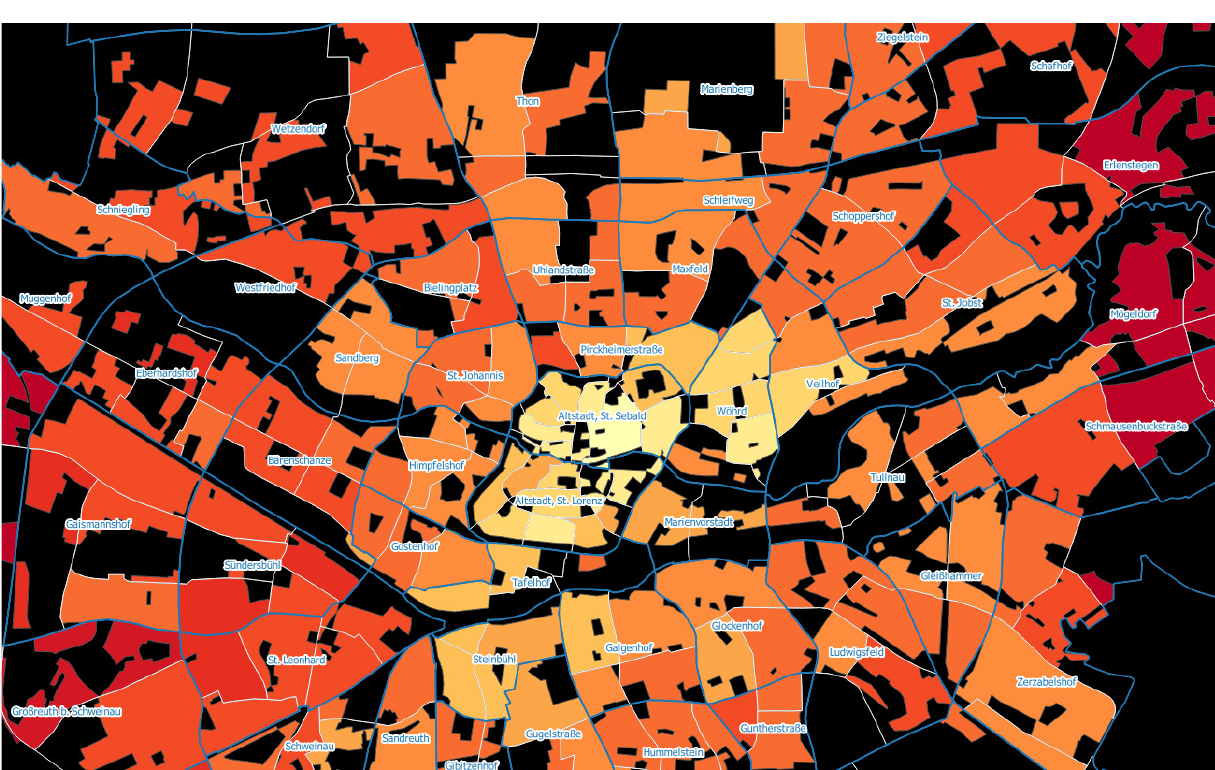
Figure 4. The BDI at the district level reflects the colours of the historical map. Note: Bright yellow highlighting the highest values of damage; dark red indicating the lowest values; black for open spaces and districts with no damage. the later period of 1969 for comparative